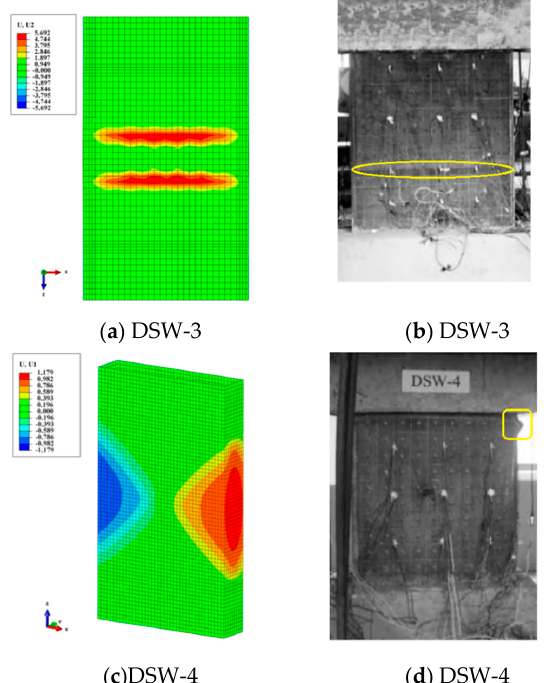
Figure 9. Comparisons of the failure modes between those from the FE simulations and the experimental tests.